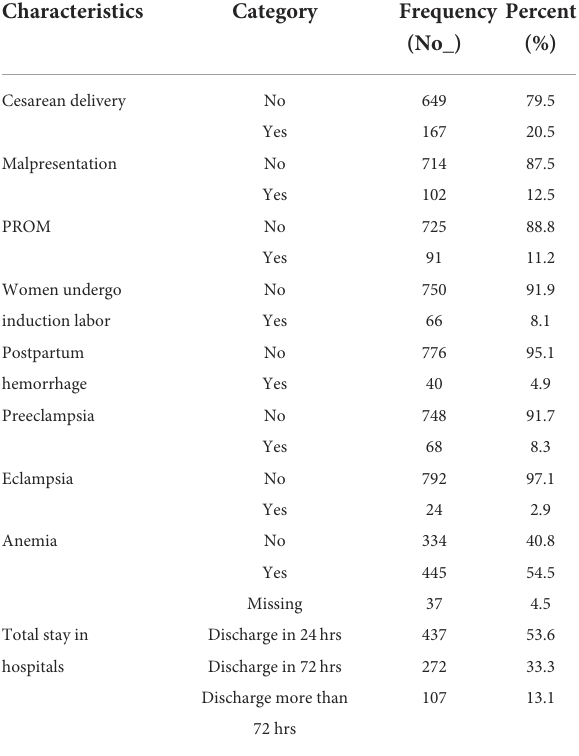
TABLE 2 Adverse maternal outcome characteristics in five governmental hospitals in Ethiopia’s Sidama regional state in 2021. N =